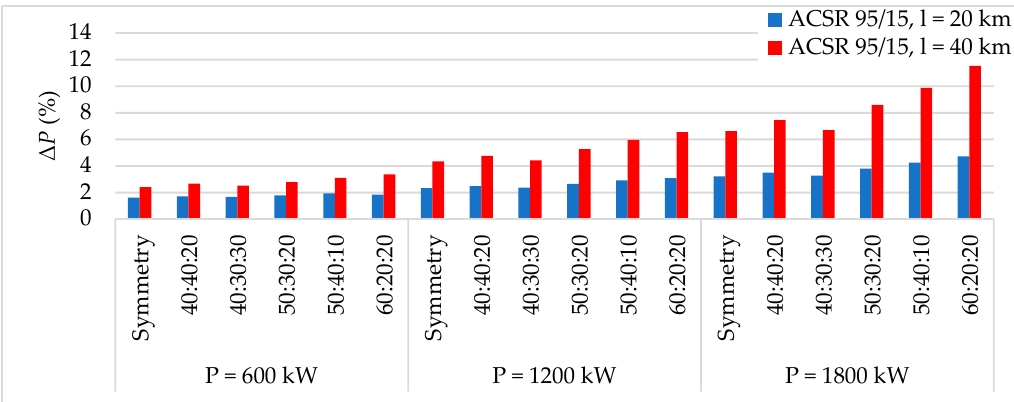
Figure 23. The comparison of the APLs for three types of active powers for conductor ACSR 95/15.